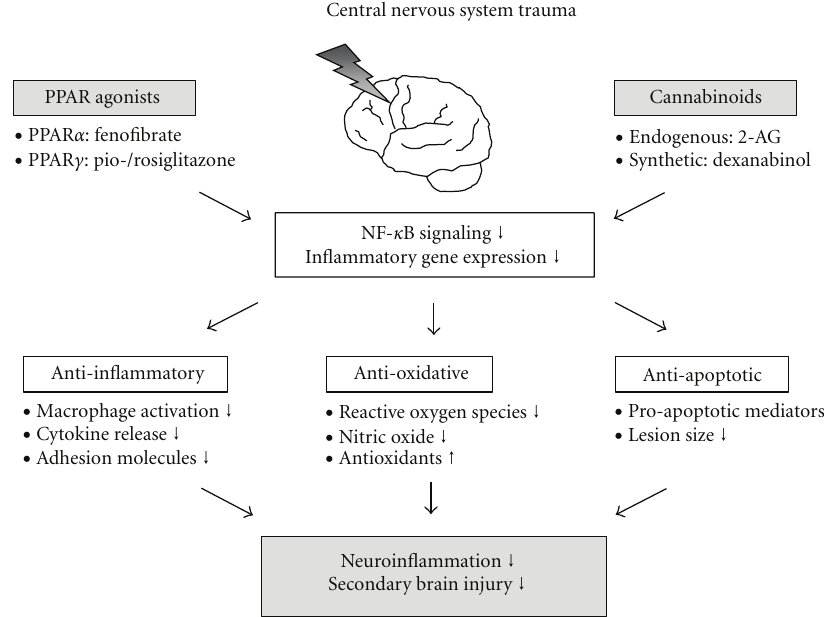
Figure 1: Overview of the anti-inflammatory and neuroprotective e ff ects of selected PPAR agonists in central nervous system (CNS) injury, as exemplified in the setting of traumatic brain injury. See text for detailed explanations. Abbreviations: PPAR , peroxisome proliferator- activated receptor ; 2-AG , 2-arachidonyl glycerol ; NF- κ B , nuclear factor- κ B ; CNS , central nervous system